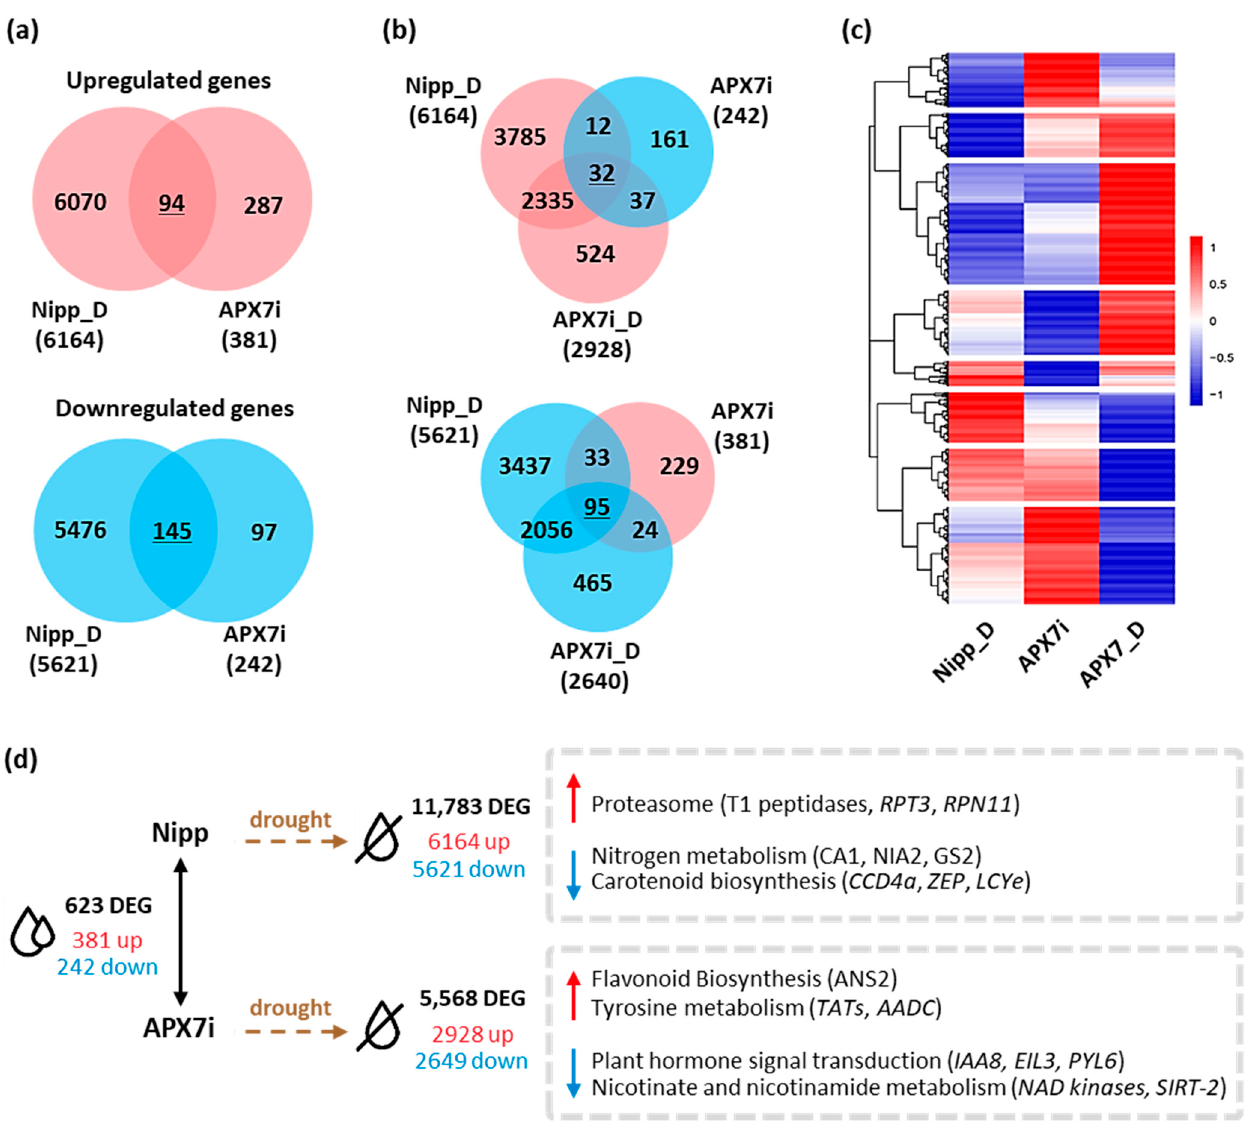
Figure 9. Differentially expressed genes in Nipponbare (Nipp) and APX7i rice plants under drought conditions. ( a ) Venn diagrams representing shared up- and down-regulated genes in Nipp plants under drought conditions (Nipp_D) and compared to untreated APX7i plants. Red circles represent up-regulated genes, and blue circles represent down-regulated genes. ( b ) Venn diagrams represent genes up- and down-regulated in both Nipp and APX7i plants under drought conditions (Nipp_D and APX7i_D) that display an inverse regulation profile in untreated APX7i plants. ( c ) Heatmap of 1462 differentially expressed genes, consisting of the intersections displayed in A and B, along with other induced and repressed genes in APX7i plants under drought conditions that are not differentially expressed in untreated APX7i plants. Red and blue shades indicate up- and down-regulated genes, respectively. ( d ) Differentially expressed genes between APX7i and Nipp rice plants and KEGG pathways enriched under drought treatment.